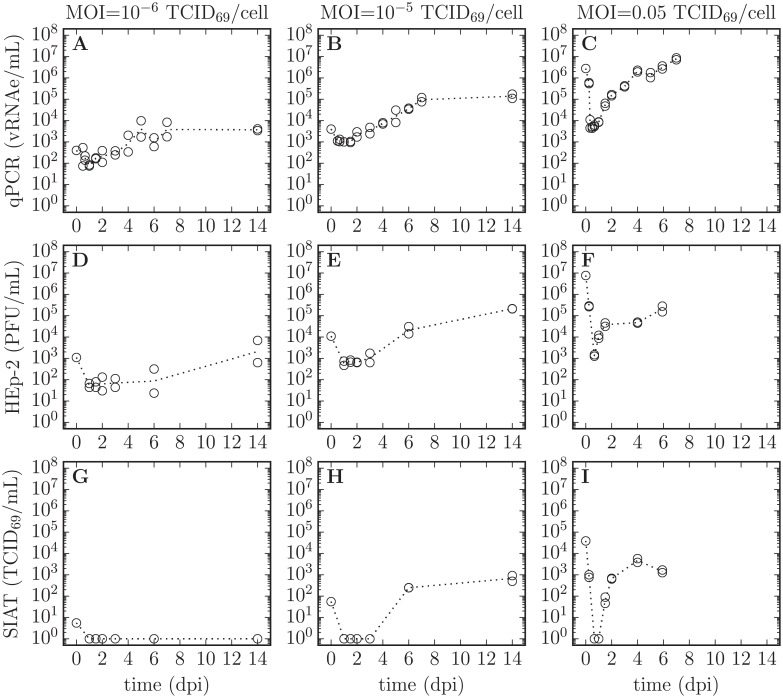
Time course of in vitro RSV infection in SIAT cells.SIAT cells were infected in duplicate with 3 different dilutions (MOIs) of an RSV A Long inoculum. Over the course of the in vitro RSV infections, the supernatant was sampled multiple times to establish RSV infection kinetics. The total RSV concentration was measured via qRT-PCR (vRNAe/mL, A, B, C), whereas infectious RSV concentration was quantified both on HEp-2 cells (PFU/mL, D, E, F) and on SIAT cells (TCID69/mL, G, H, I). Duplicate measures (two symbols) rather than error bars are plotted at each sampling time point, though in some cases only one point is visible. A dashed line joins the geometric mean of the measures at each sampling time point.